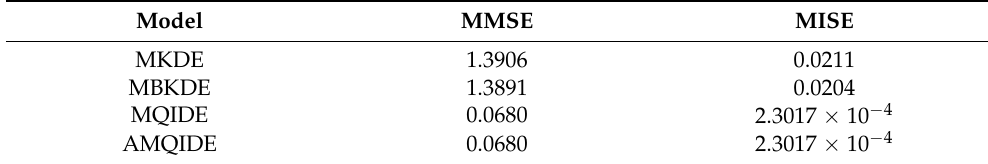
Table 3. Accuracy of bivariate